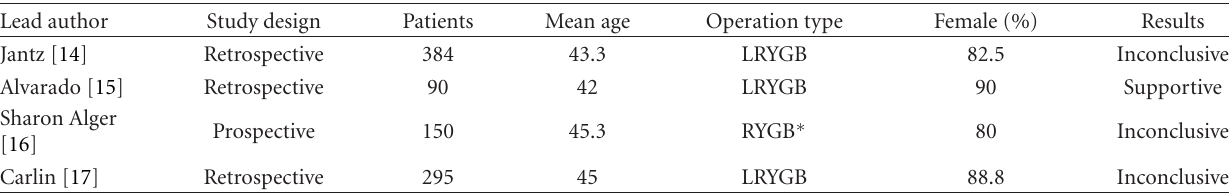
Figure 5: Flow chart depicting the classification of the selected studies into Class A, B, and regression studies. WL: weight loss; WG: weight gain. Table 3: Regression